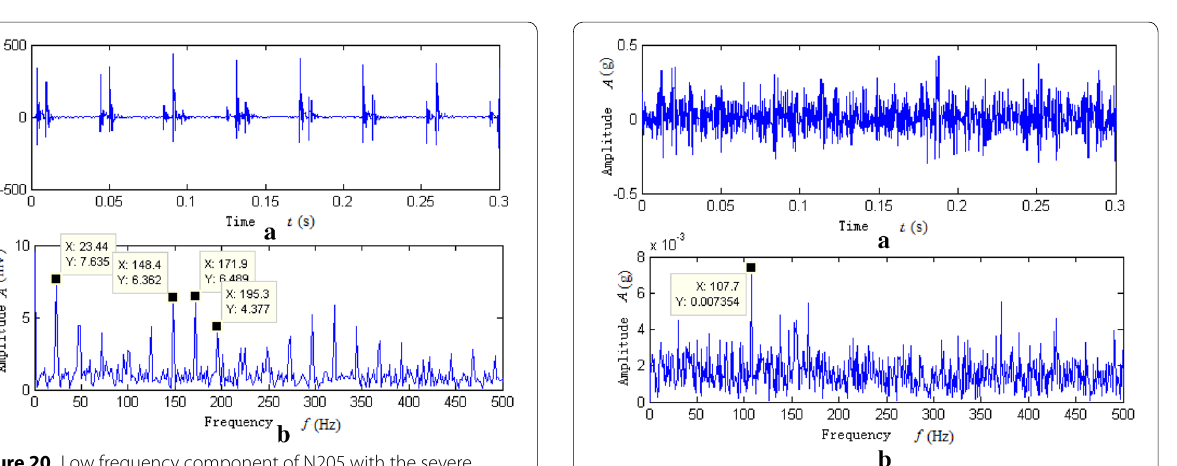
Figure 22 Filter result of 6205 with the slight defect on the outer race: ( a ) time waveform, ( b ) local spectrum